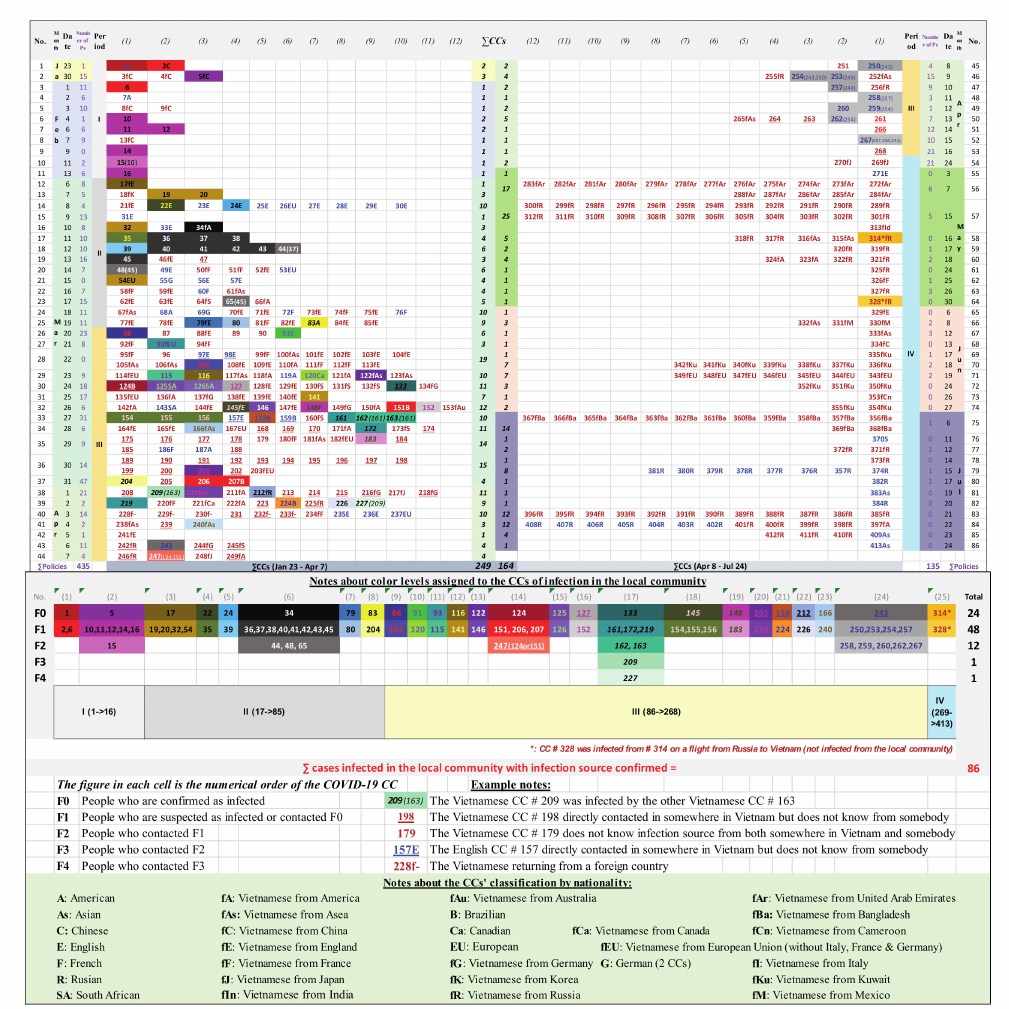
Figure 1. Chronology of COVID-19 confirmed cases (CCs) and the numbers of policy documents (PDs) in Vietnam (as of 24 July